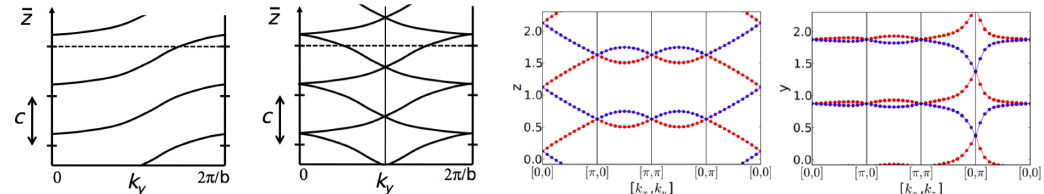
Figure 12: (far left) Flow of Wannier charge centers along ˆ z vs. k insulator. (middle left) Flow of Wannier charge centers along along ˆ z vs. k quantum spin Hall layer. (right) Flow of Wannier charge centers in hybrid Wannier representation for 3D 3D Fu-Kane-Mele model. From Ref. [ 67 ]